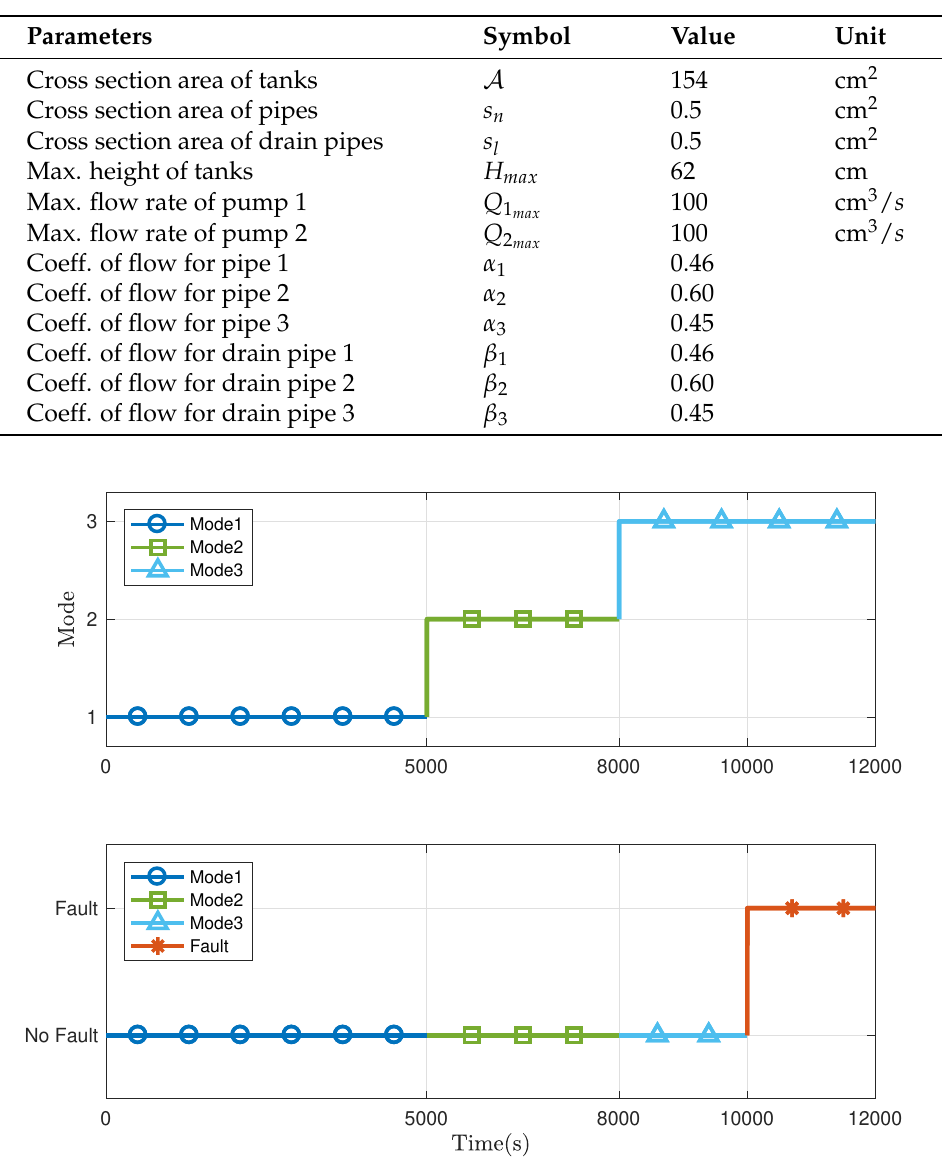
Figure 4. Switching law and fault signal of the three-tank